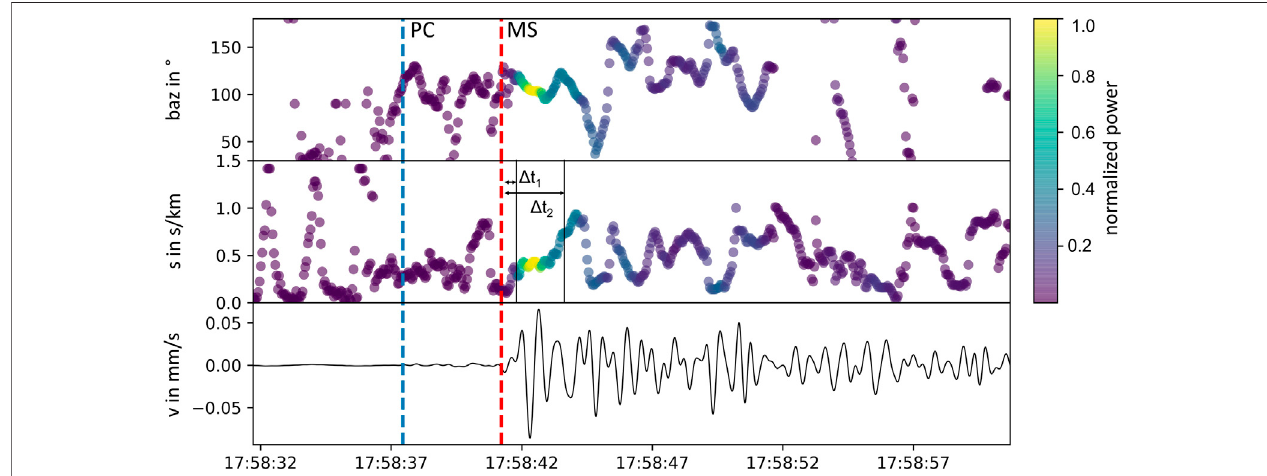
FIGURE4| Slowness(s)andbackazimuth(baz)ofaseismicexplosionsignalmeasuredwiththeseismicarrayinadistanceof2 kmtothedomeon7.1.19.Theblue and the red dashed lines indicate the onset of PC and MS, respectively. The color code of the slowness and baz corresponds to the normalized power of the seismic signal shown below. Δ t 1 (cid:1) 0.5 s and Δ t 2 (cid:1) 2.5 s show the time difference of MS onset and slowness